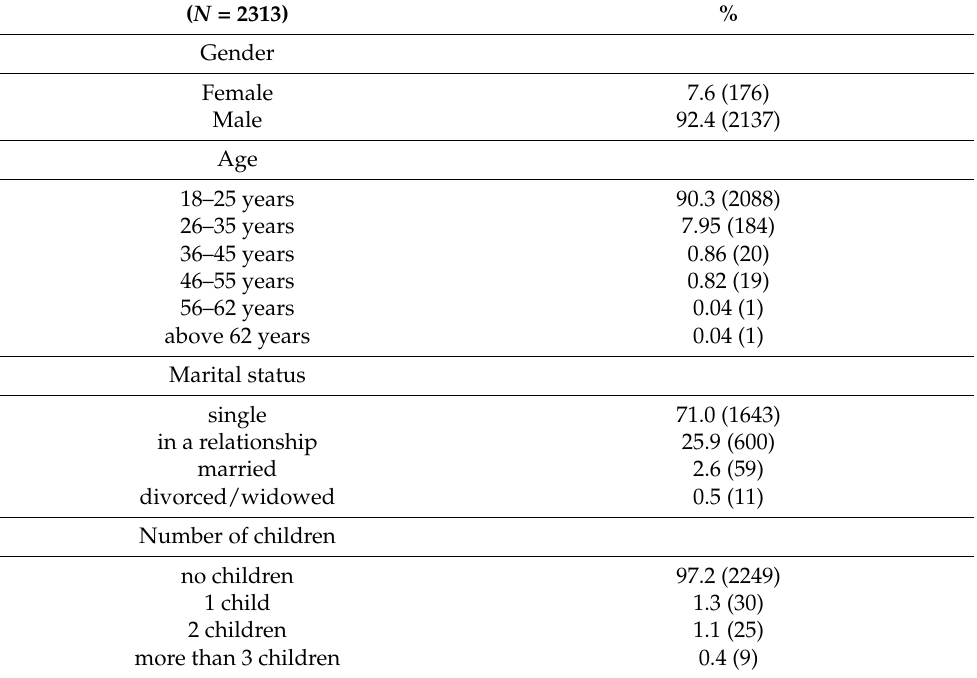
Table 1. Characteristics of the study